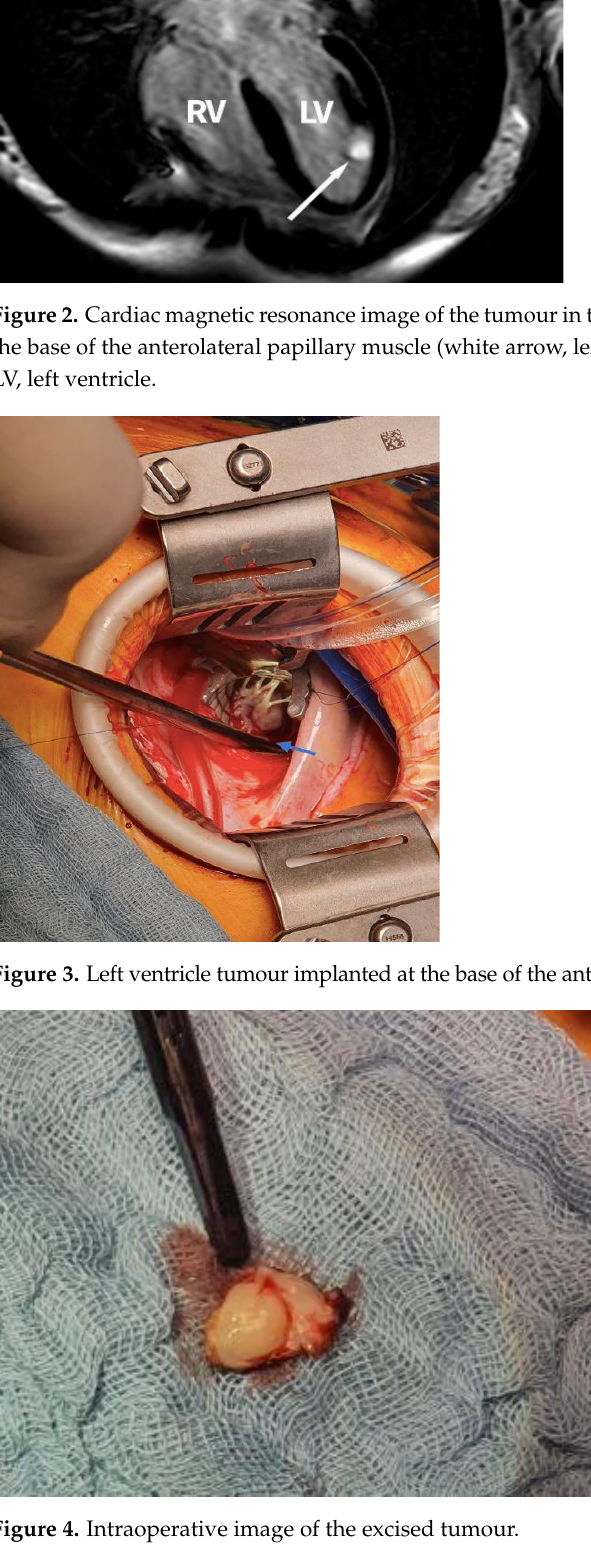
Figure 4. Intraoperative image of the excised tumour .